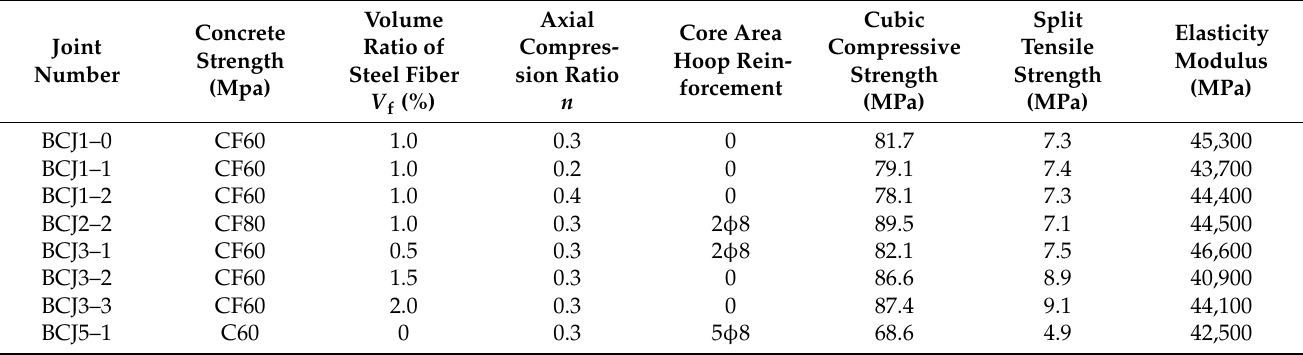
Table 2. Test parameters of SFRC–BCJs specimen.